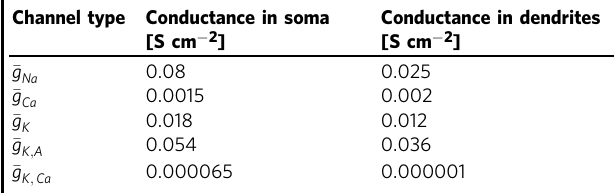
Table 4 Reference distribution of ion channels in cell